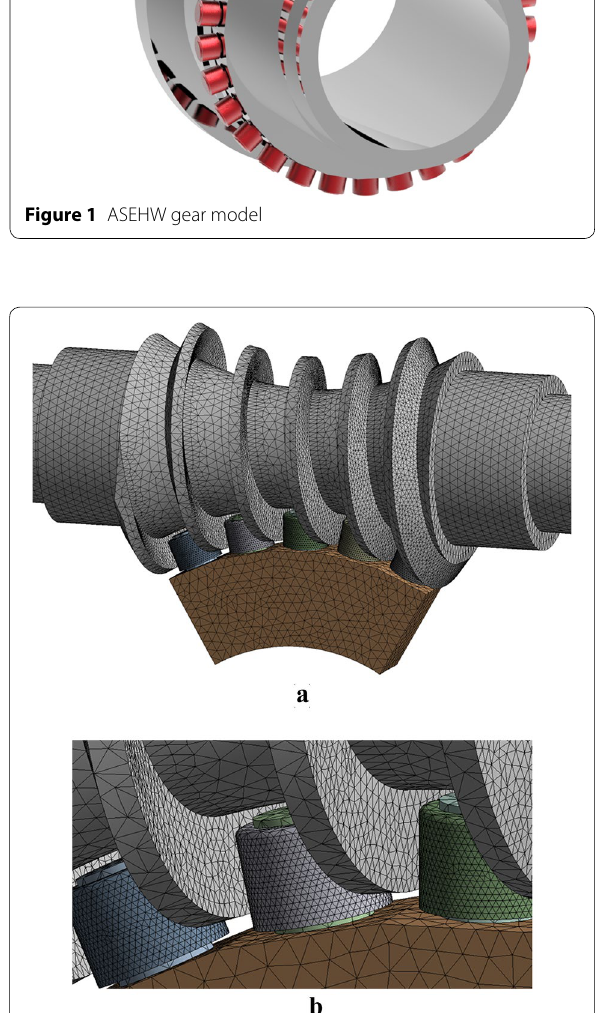
Figure 2 a Global meshing, b refinement meshing